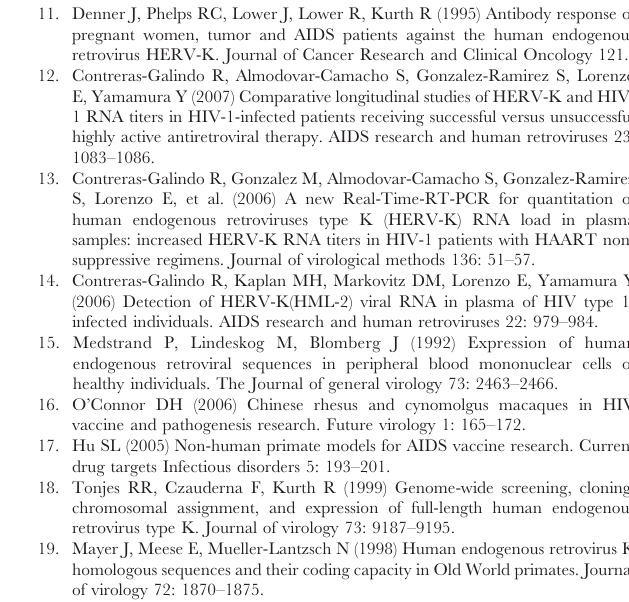
primer sequences and amplicon sizes of each gene are listed in Table 1. Representative qPCR amplicons were analyzed by gel electrophoresis on a 2% agarose gel to confirm the size and purity of the products. In addition, select qPCR products were sequenced to confirm the transcripts. The RT-qPCR assay consistently demonstrated high efficiency and linearity for each gene (Table 1). The standard curve was used to enumerate CyERV mRNA expression. Sequence Detection System v2.4 (Applied Biosystems) was used for gene expression analysis with CyERV expression levels being standardized to 1 m g of RNA, normalized to the GAPDH reference gene and log transformed. Values represent the mean of the three technical replicates. Threshold cycle values or quantitative values that were deemed outliers based on Grubbs’ test (Z $ 1.15) were excluded.